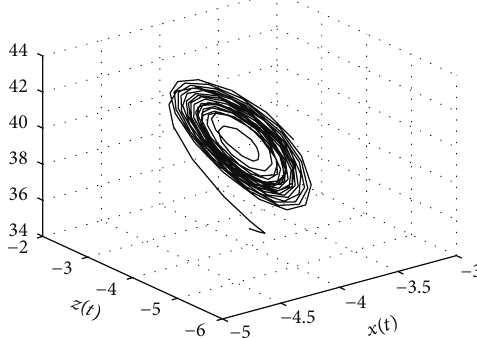
Figure 13: For system (97), an unstable periodic solution bifurcates from the steady state 𝑆 − when 𝑘 1 = −3 , 𝜏 = 1.5